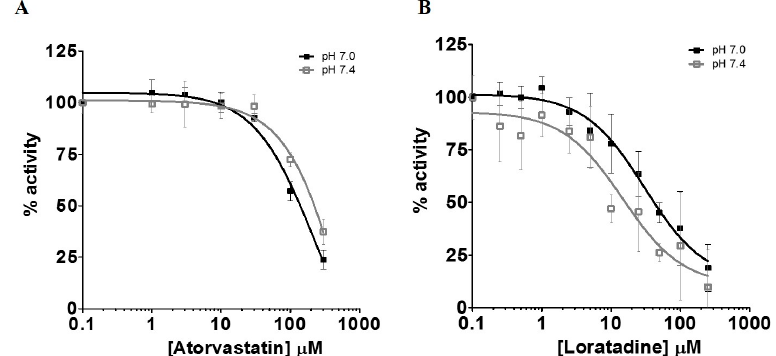
Figure 6. Inhibition of MCT-mediated efflux transport of L -lactic acid measured by the intracellular accumulation of L -lactic acid in the presence of atorvastatin ( A ) or loratadine ( B ). IC 50 were determined at pH 7.0 and 7.4. The percentage of remaining activity was derived by substracting the maximal level of L -lactic acid after equilibrium to the residual intracellular L -lactic acid concentrations at the end of the experiment.